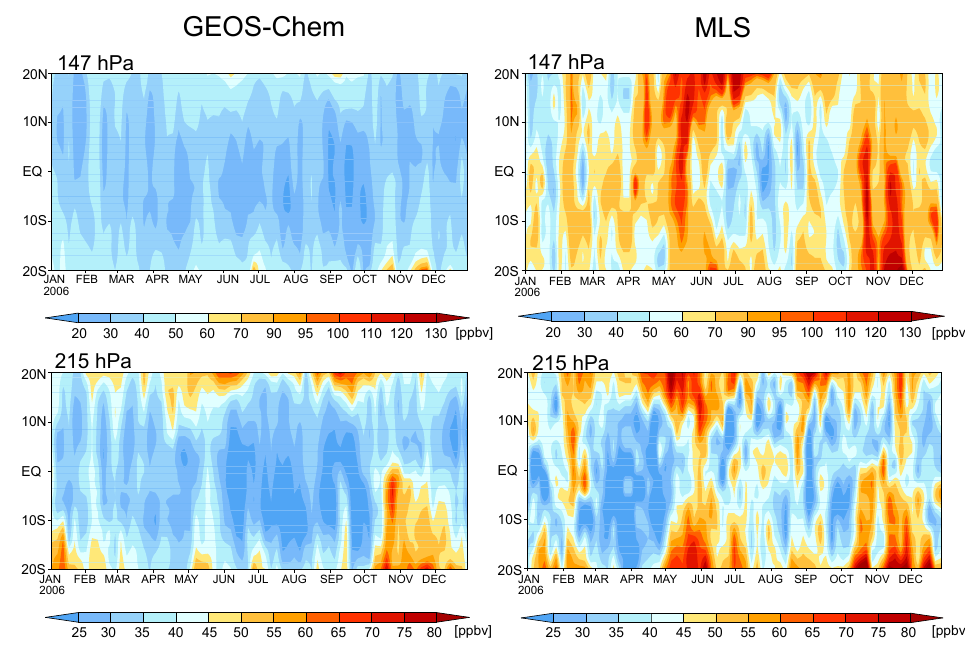
Fig. 8. Same as Fig. 6, but for O 3